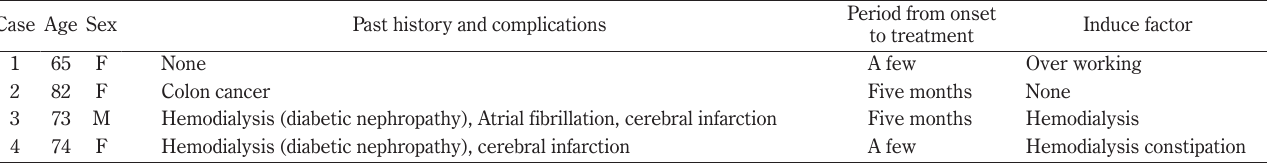
Table 1 Patient